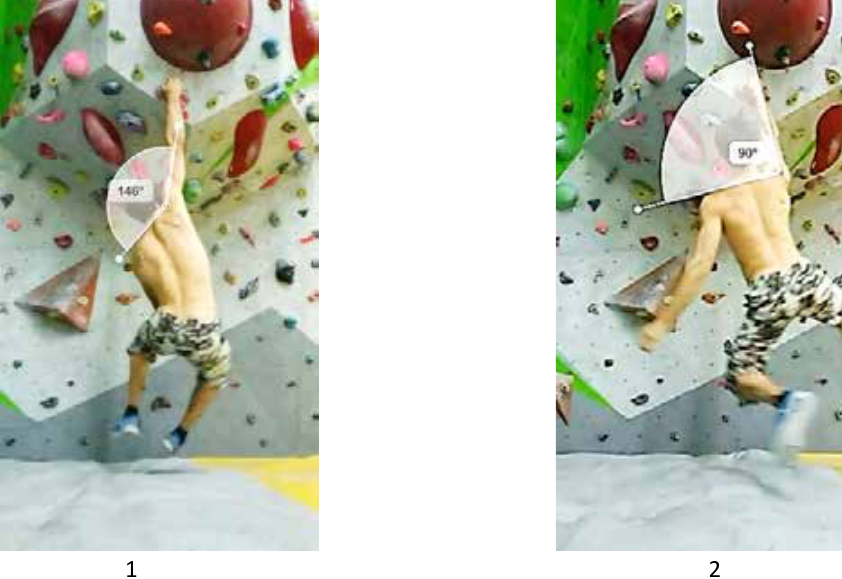
Fig. 1. The phase of fixing the hang in rock climbing, model of technique 1, is typical for beginners (1) and model of technique 2, is typical for qualified athletes (2)